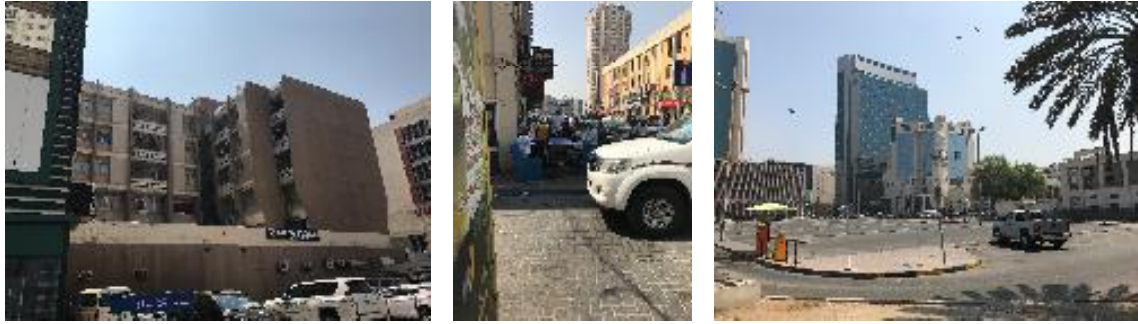
Figure 21: low quality of dealing with building Facades designs